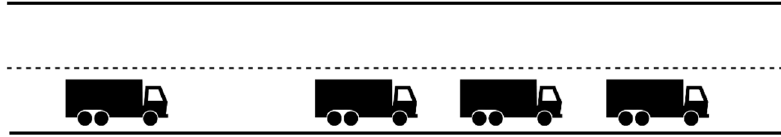
Figure 2. Three trucks drive in a platoon and use the slipstream to reduce fuel consumption while a fourth truck follows with a normal safety distance.